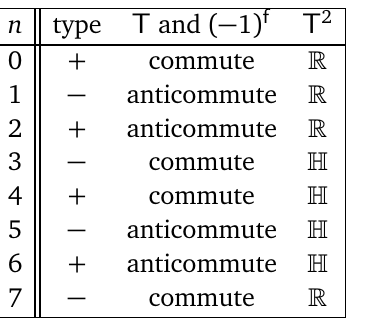
Table 4: The properties of T and ( − 1 ) f for the eight anomaly types n = 0,...,7.